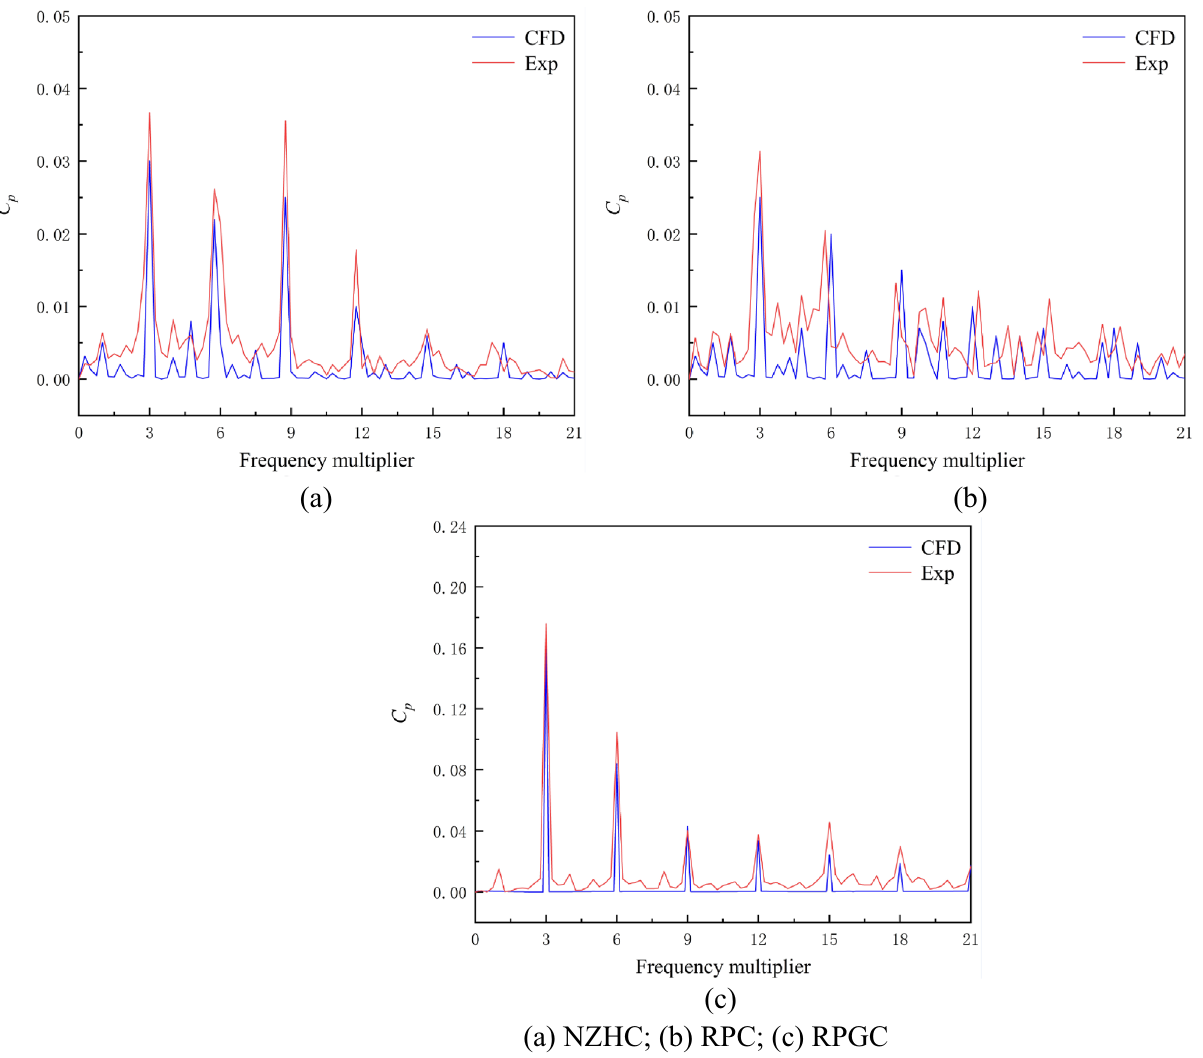
Figure 23. Comparison of the numerical simulation value and experimental value of the pressure